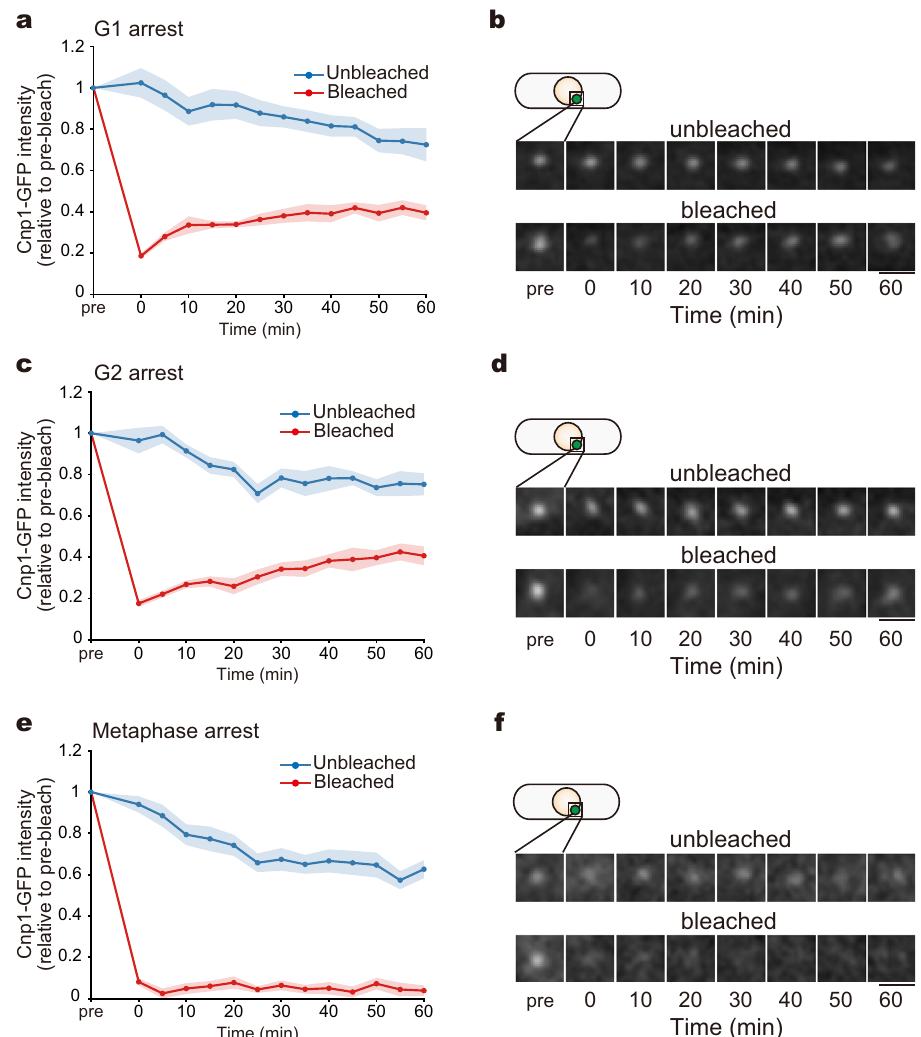
Fig. 1 Deposition of Cnp1 (CENP-A) ceases in metaphase. Fluorescence recovery after photobleaching (FRAP) assays were performed with Cnp1-GFP cells arrested at each stage of the cell cycle. Cells with unbleached centromeres were used as controls. a , c , e Recovery kinetics of Cnp1-GFP fl uorescence over time (red circles). Controls are also shown (blue circles). Intensities are shown normalised to values before bleaching (pre). b , d , f Time-lapse Cnp1- GFP images of representative cells. Cells were arrested in G1 (using the cdc10 mutant; a , b ), G2 ( cdc25 ; c , d ) or metaphase ( alp12 ; e , f ), and Cnp1-GFP dots were photobleached. Fluorescence recovery at the centromeres was then monitored over time. Numbers of unbleached and bleached cells: n = 11 and 16 ( a ); n = 9 and 9 ( c ); n = 19 and 15 ( e ), respectively. The solid lines indicate the mean value, and the coloured regions indicate the standard error (s.e.m.). Scale bars = 2 µ